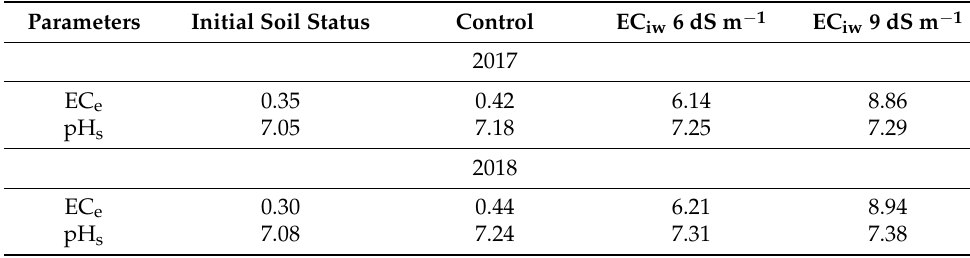
Table 1. Soil status: Before and after the experiment.